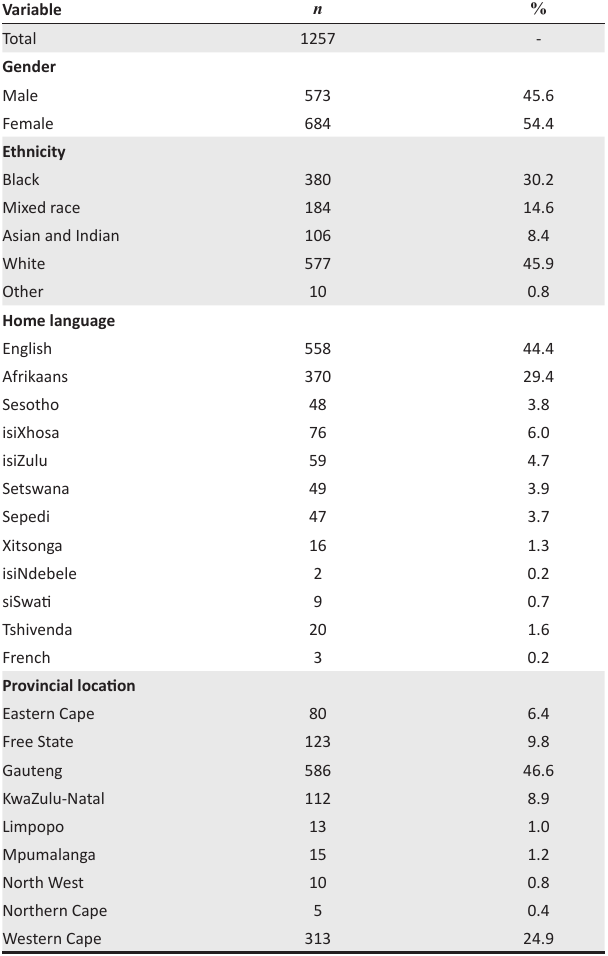
TABLE 1: Demographic statistics of the sample.